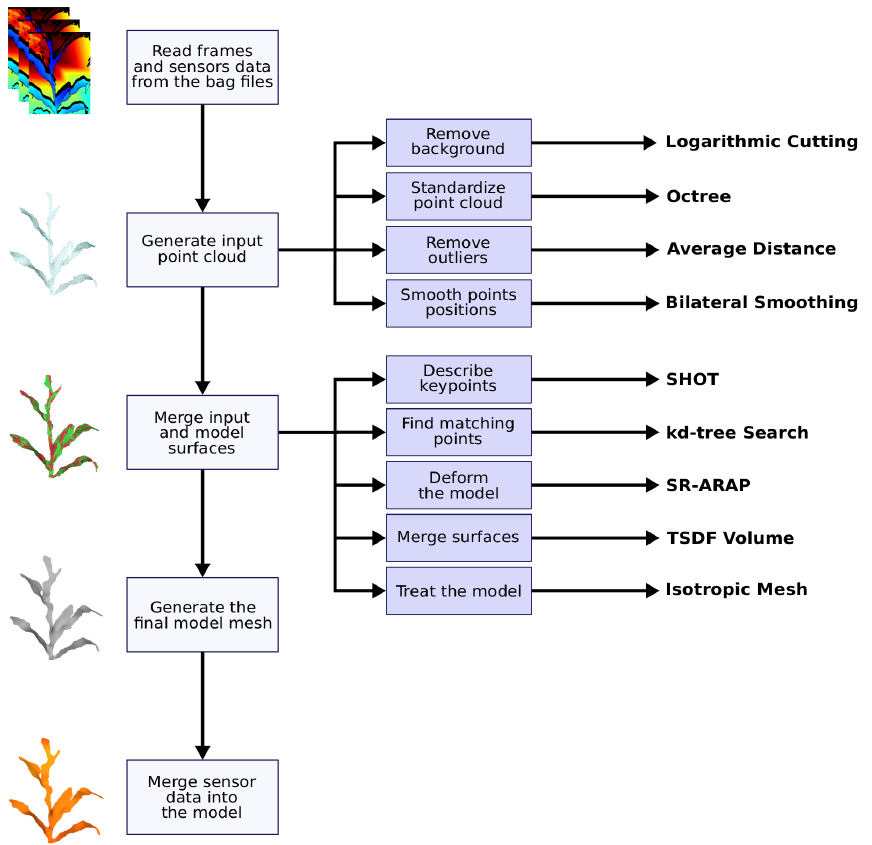
Figure 3. Proposed system processing